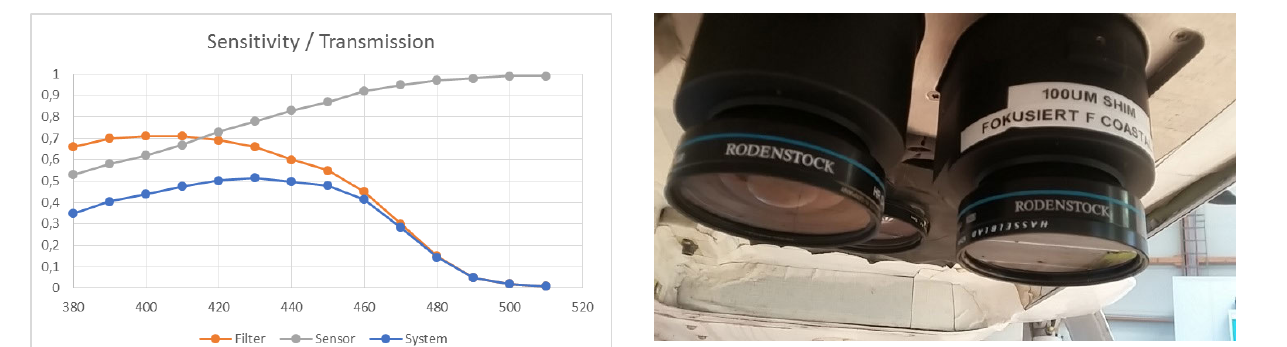
Figure 1. DigiCAM 100 Coastal Blue: Sensitivity/transmission curves of CMOS sensor (gray), filter (orange), and resulting system performance (blue) for different wavelengths [nm]